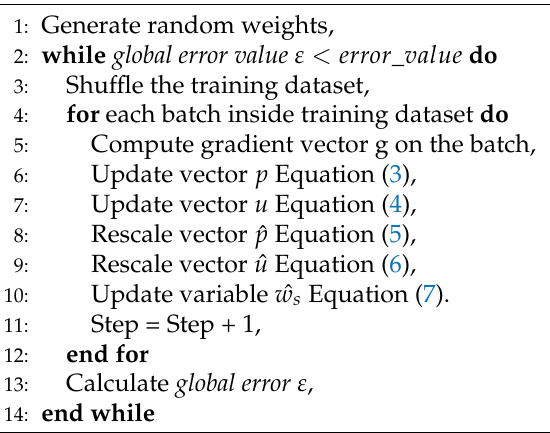
Algorithm 1 NAdam training